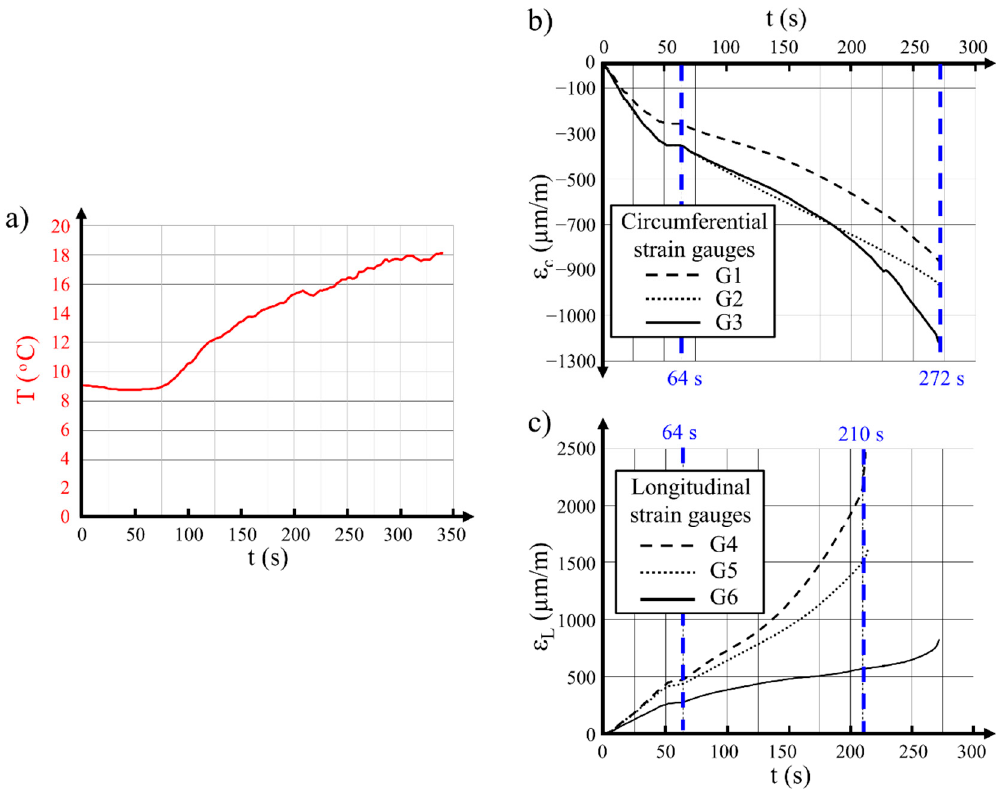
Figure 7. Results recorded during testing of the 300 mm hollow cylinder prestressed with 3 mm SMA wire—specimen R1: ( a ) temperature over time for the Ni–Ti wire; ( b ) circumferential strain for concrete; ( c ) longitudinal strain for